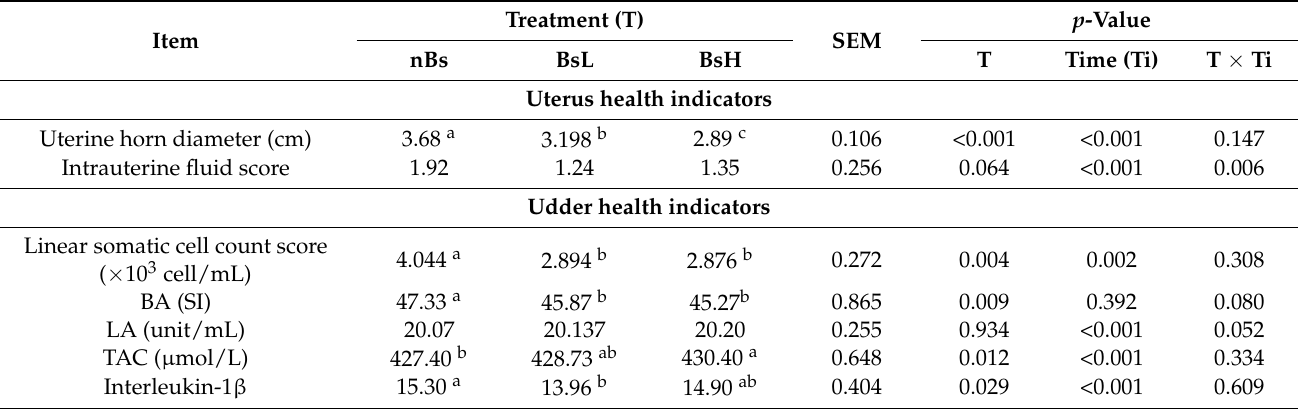
Table 4. Uterus and udder health indicators for transitioning goats that received 0 (nBS), 2 (BsL), and 4 (BsH) Boswellia sacra resin daily from week 2 prepartum to week 7 postpartum.